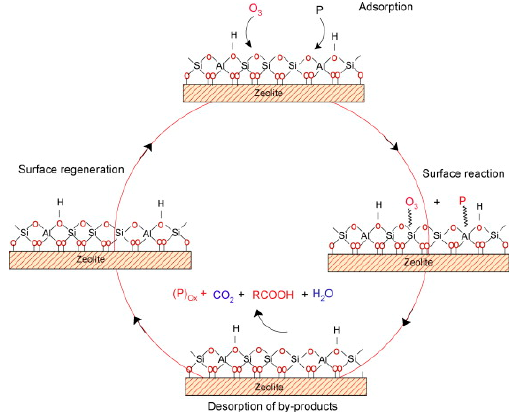
Figure 14. Proposed mechanism of catalytic ozonation on ZSM-5 zeolites (P,